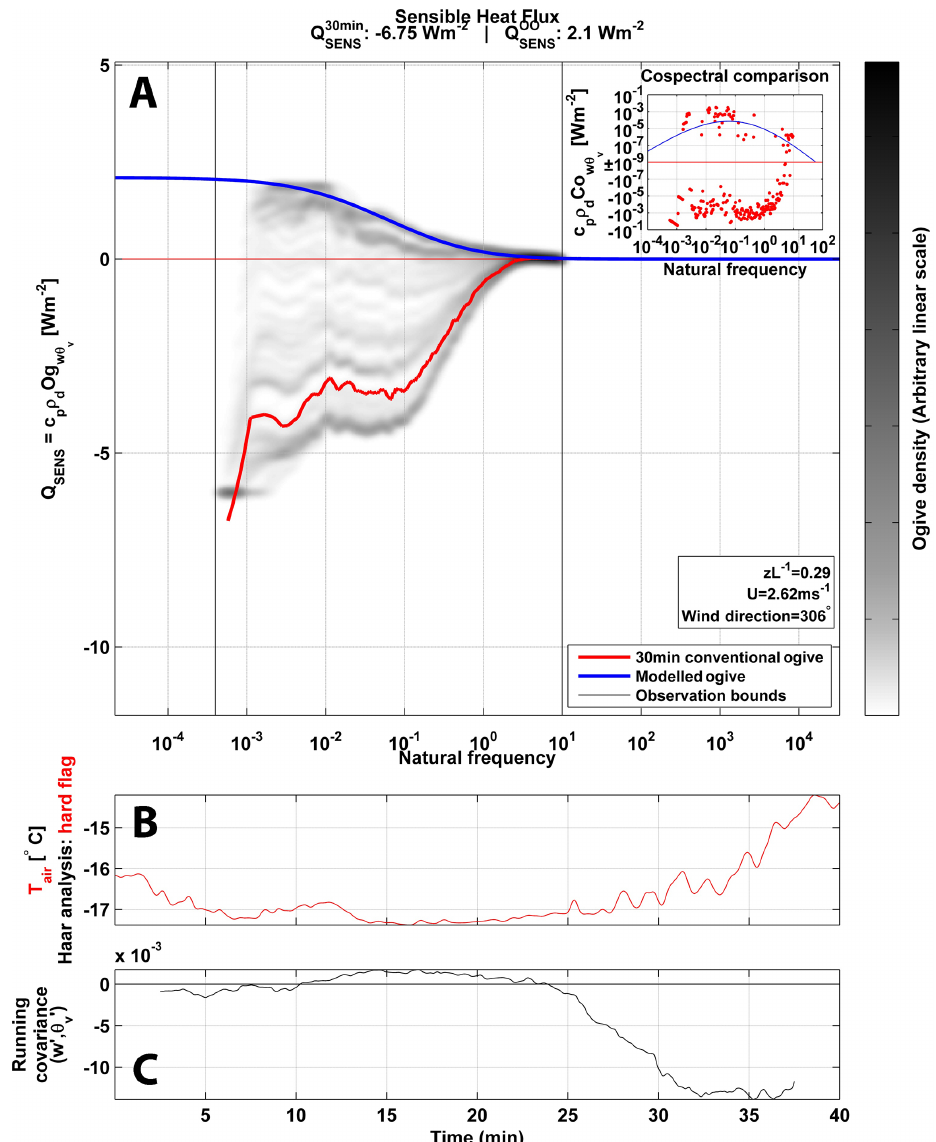
Figure 8. 40min observation of sensible heat flux recorded at Daneborg on 13 April 2012 at 3:30p.m. LT. The illustration is similar to Fig.